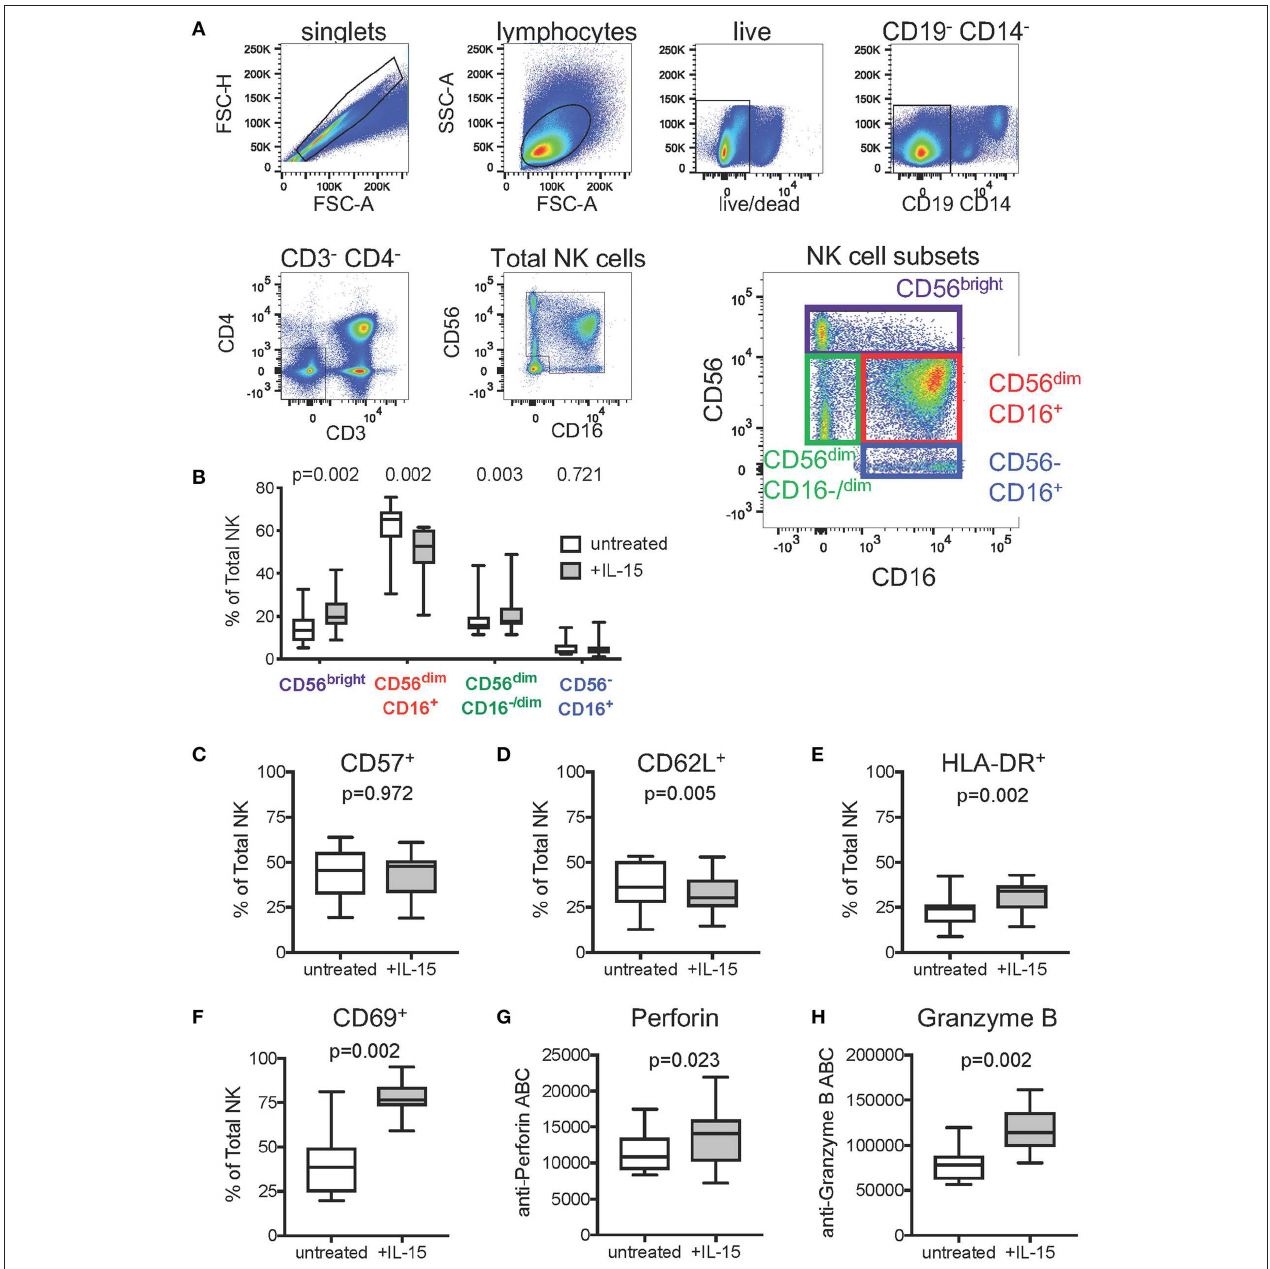
FIGURE 3 | Effect of exogenous IL-15 treatment on phenotypes of natural killer (NK) cells. (A) Gating strategy used to identify total NK cells and NK cell subsets. Concatenated data representing all samples ( n = 30, 15 PBMC donors ± IL-15) was included in the flow plots. (B) Comparison of NK cell subset frequencies when untreated, and after overnight treatment with 10ng/ml IL-15 ( n = 15 paired PBMC samples per condition). Frequencies of total NK cells expressing (C) CD57, (D) CD62L, (E) HLA-DR, and (F) CD69 in cells left untreated or treated overnight with 10ng/ml IL-15. Amount of intracellular (G) perforin and (H) Granzyme B in NK cells left untreated or after overnight treatment with 10ng/ml IL-15, represented as antibody binding capacity (ABC), which is determined from the mean fluorescence intensity (see Methods). In (B–H) , box plots represent the interquartile ranges, horizontal lines indicate the medians, and error bars extend to the minimum and maximum observed values. P -values were calculated with paired Wilcoxon rank sum tests and were adjusted for multiple comparisons to control for false discovery rate via the Benjamini-Hochberg method.